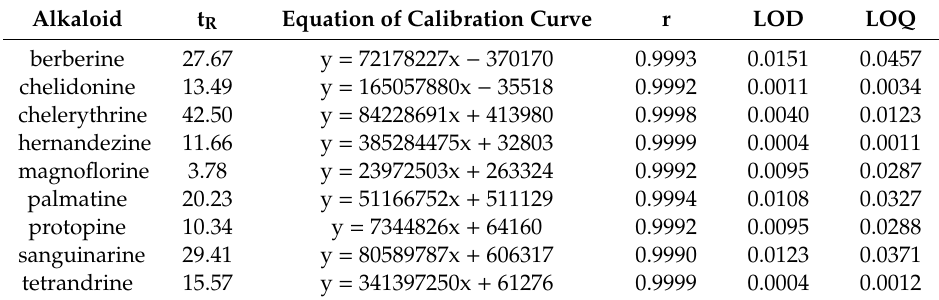
Table 1. Equation of calibration curve, correlation coe ffi cients (r), limit of detection (LOD) and limit of quantification (LOQ)